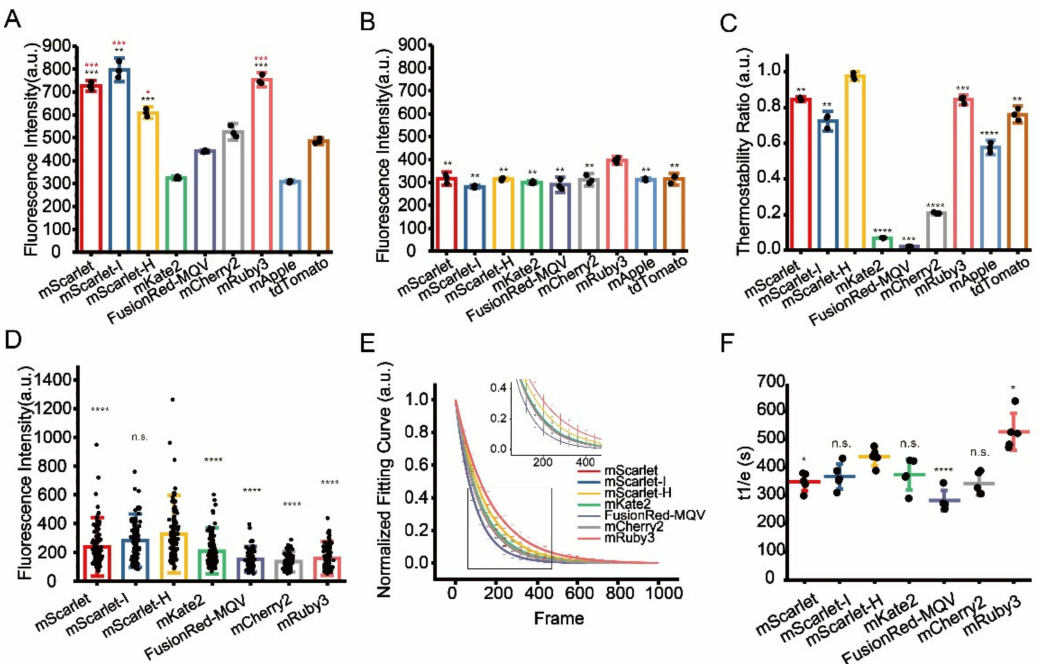
Figure 2. Identification of optimal RFPs for CLEM imaging. ( A ) Residual fluorescence intensity of RFPs after 1% OsO 4 post-fixation. Red stars represent comparisons to mCherry2, black stars represent comparisons to mKate2. ( B ) Residual fluorescence intensity of RFPs after 1% OsO 4 post-fixation followed by absolute ethanol dehydration. ( C ) Thermostability of RFPs at 60 ◦ C. ( D ) Fluorescence intensity of RFPs on Epon-embedded sections (100 nm). ( E ) Normalized photobleaching curves of RFPs on Epon-embedded sections (100 nm). Enlarged view of the boxed area is shown on top. ( F ) Statistics of the photobleaching time when the fluorescence intensity of RFPs reduced to 1/e of their initials. Bars represent mean ± SD. p values were determined with two-tailed t -tests in ( A – C ) ( n = 3) and ( F ) ( n = 5), Mann–Whitney U test was performed in ( D ) ( n = 106). n.s. indicates p > 0.05, * indicates p < 0.05, ** indicates p < 0.01, *** indicates p < 0.001, **** indicates p < 0.0001. Data are summarized in Tables S10, S11, S13, S14 and